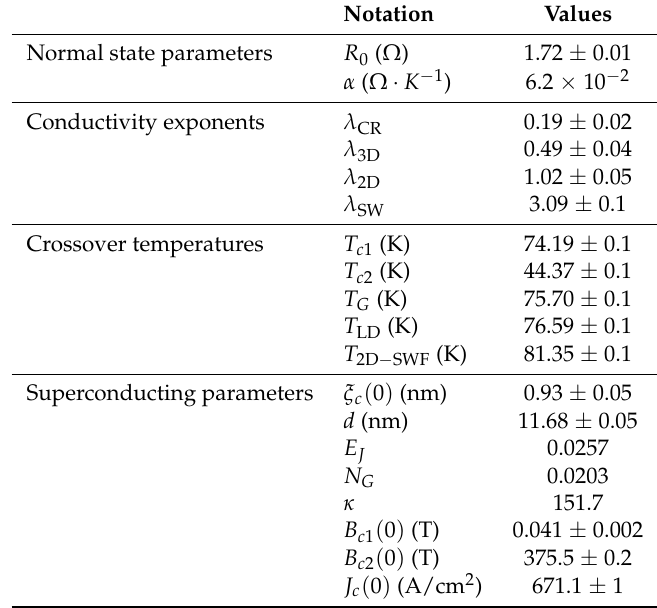
Table 1. Conductivity exponents, crossover temperatures, and superconducting parameters for the Bi-2212